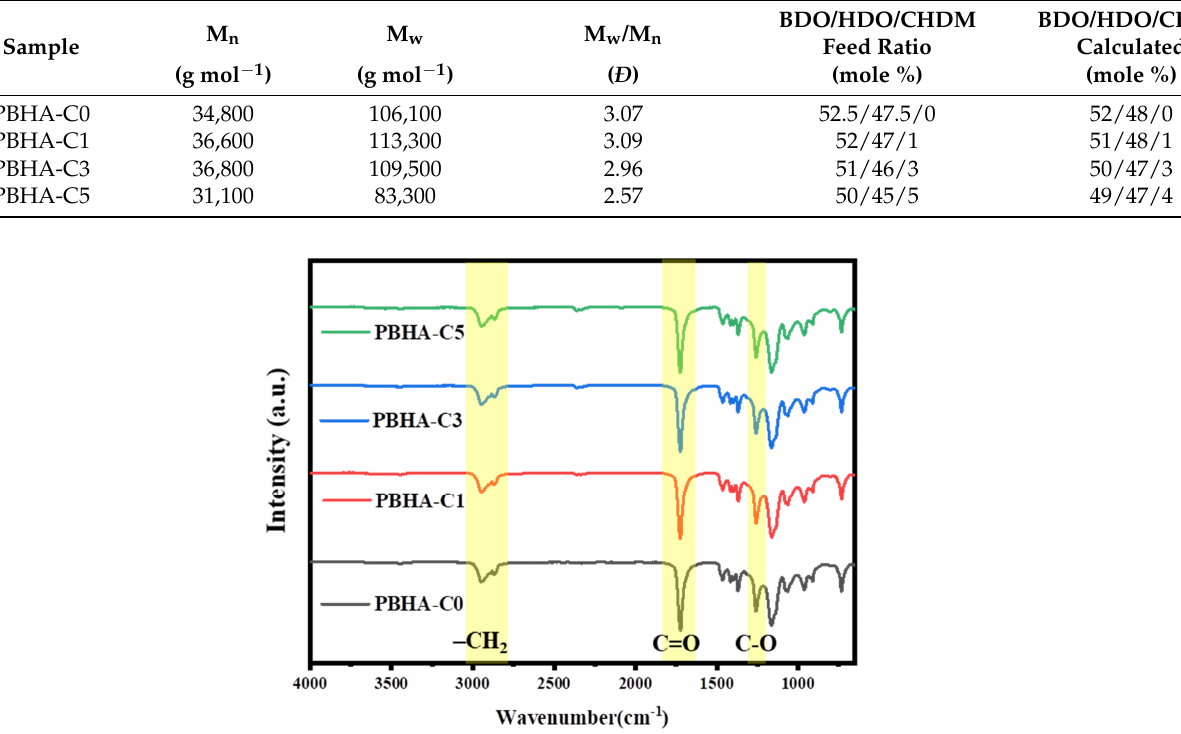
Table 1. Molecular weight from GPC results and the feed and calculated ratios of PBHA-Cn copol- ymers from NMR.